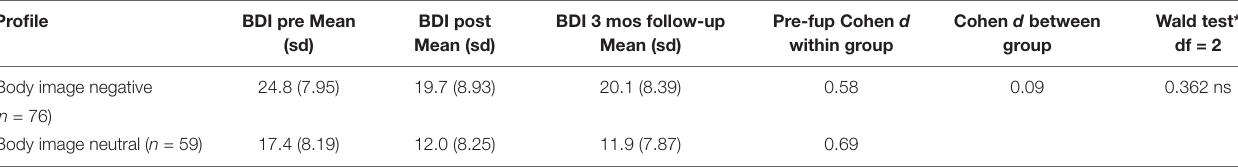
TABLE 5 | The BDI change patterns in the body image negative and body image neutral